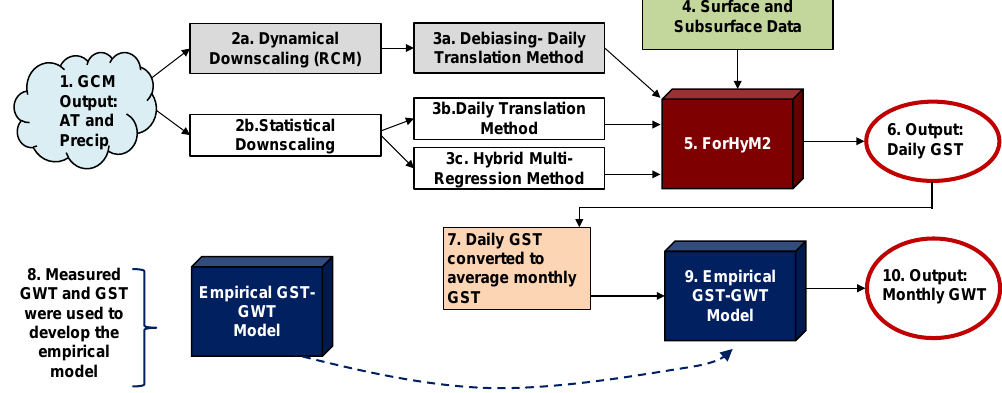
Fig. 5. Translation of GCM-simulated data into daily GST-simulations. Daily GST were then averaged on a monthly basis and entered as input to the empirical GST-groundwater temperature (GWT) transfer